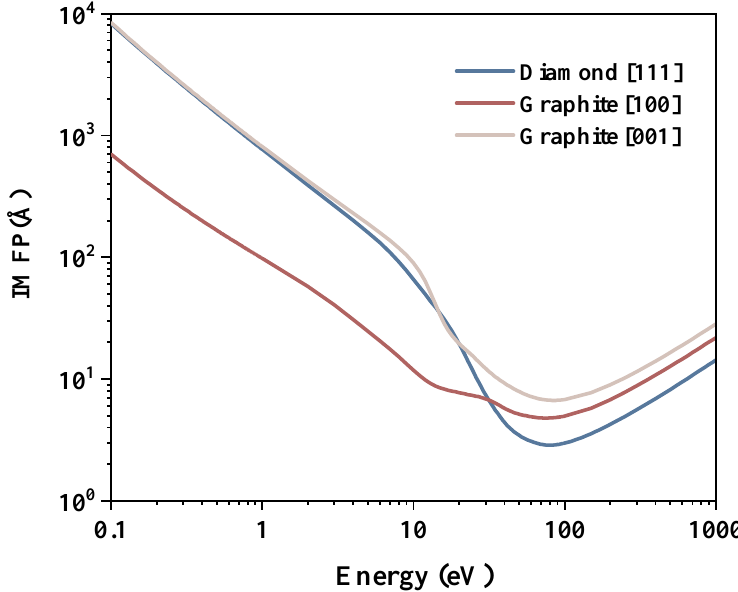
Figure 4. IMFP of diamond in the [111] direction and of graphite in the [100] and [001] directions.